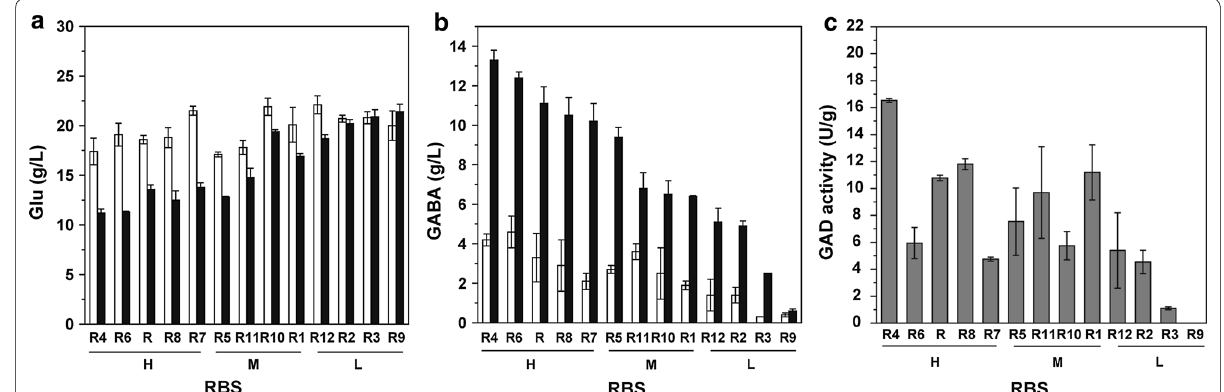
Fig. 1 GABA production and GAD activity of gadB2 -expressing C. glutamicum strains under different RBS sequences. a Glu concentration, b GABA concentration, c GAD activity. White bars at 36 h, black bars at 72 h, grey bars at 40 h. H high level of GABA, M medium level of GABA, L low level of GABA. Each point represents the average of three independent